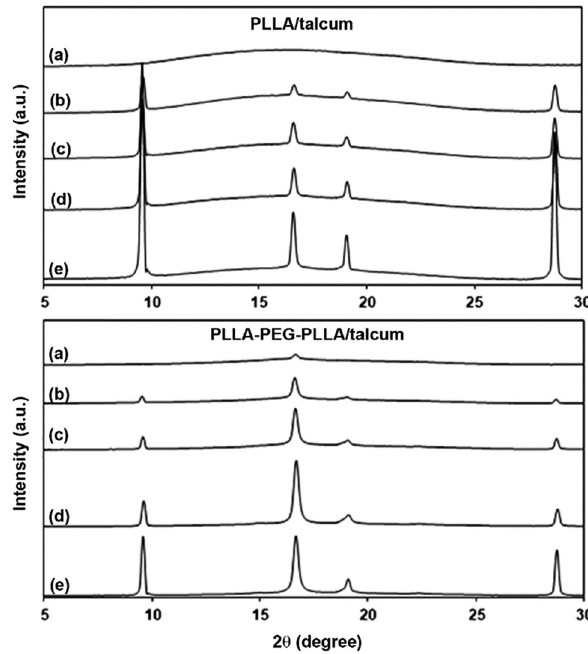
Figure 5: XRD patterns of ( above ) PLLA/talcum and ( below ) PLLA - PEG - PLLA/talcum fi lms ( a ) without talcum and with talcum